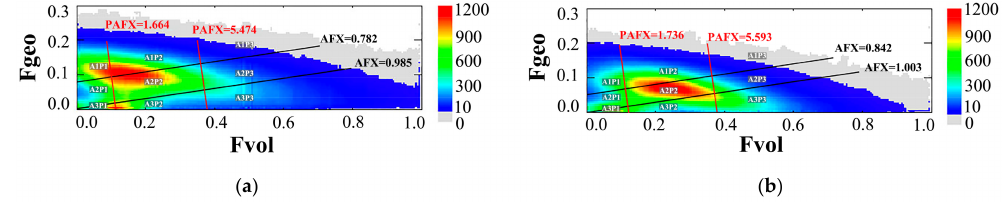
Figure 5. The distribution of normalized MODIS BRDF parameters in the red band ( a ) and the NIR band ( b ), the color indicates the density of the point. The lines are the threshold of AFX and PAFX when data is classified into 3 classes by AFX and PAFX, respectively.